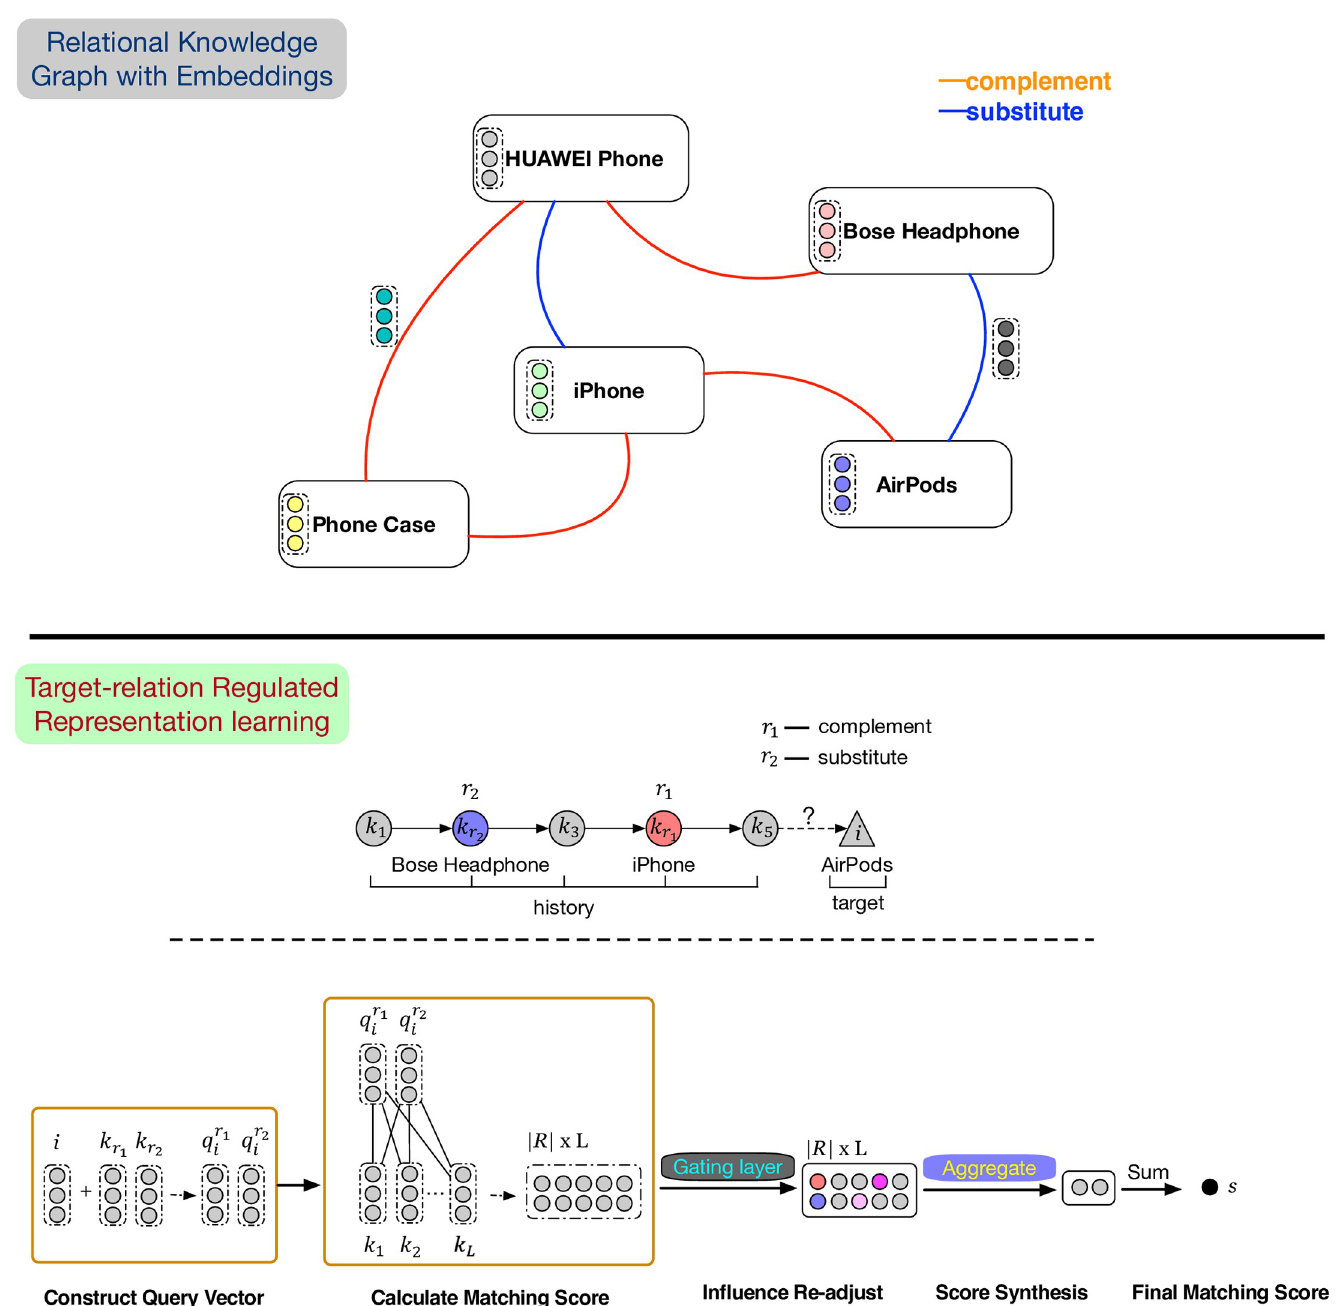
Fig 2. Illustration of the proposed model TRR. The first part pays attention to encoding the structural information constructed by the knowledge graph of item relations into their embeddings. The second part focuses on learning the target-relation regulated representation for the recommendation task based on the embeddings learned from the first